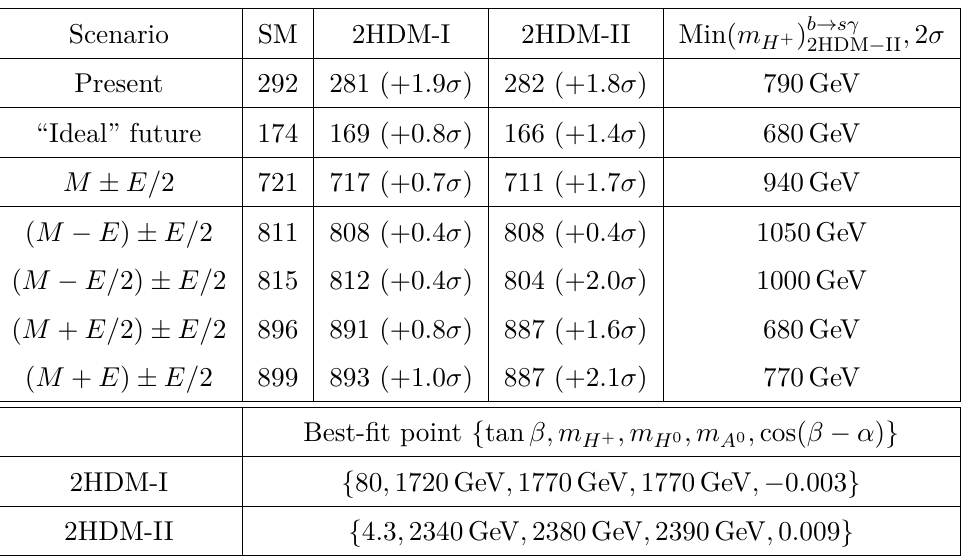
Table 4 . Summary of future prediction scenarios and their χ 2 best fits. For the 2HDMs in brackets are the pulls from the SM where a positive value indicates an improvement and a negative value a worsening. The results are shown for excluding R . Also shown is the variation of the lower D ( ∗ ) ,K ( ∗ ) bound of the charged Higgs mass in the 2HDM-II from ¯ B → X s γ